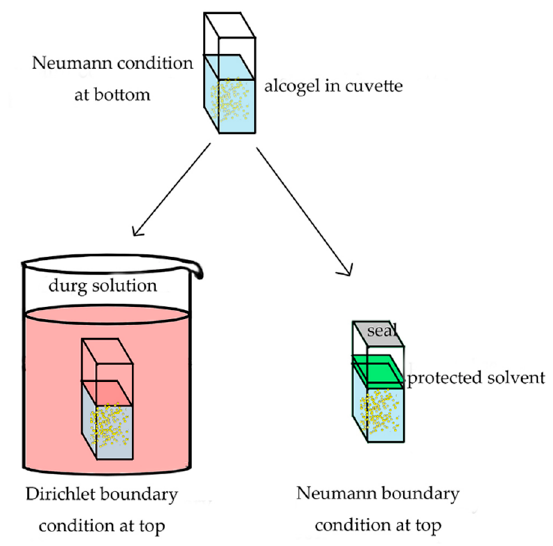
Figure 9. One-dimension diffusion model: prepare alcogels in cuvettes and kinds of boundary conditions.